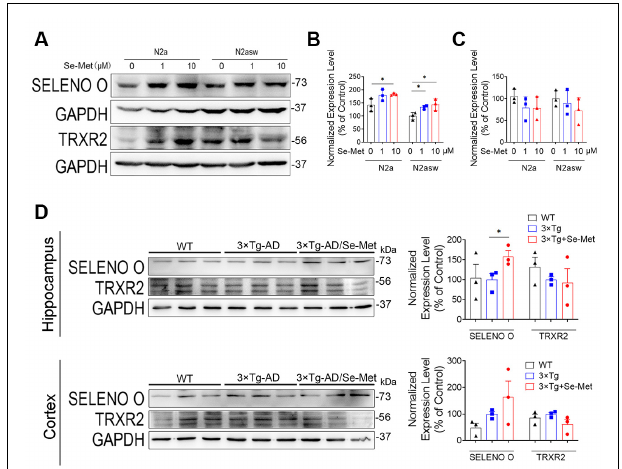
FIGURE 8 | Se-Met may attenuate mitochondrial dysfunction by upregulating SELENO O both in vivo and in vitro . (A–C) Expression of SELENO O and TRXR2 in N2a and N2a-SW cells treated with 10 µ M Se-Met. (A) The results of quantitative analyses of the expression levels of SELENO O (B) and TRXR2 (C) are shown ( ∗ p < 0.05 vs. the control group, n = 3). (D) Expression and quantified levels of SELENO O and TRXR2 in the hippocampi and cortices of 3xTg AD mice ( ∗ p < 0.05 vs. AD mice, n = 3 mice).